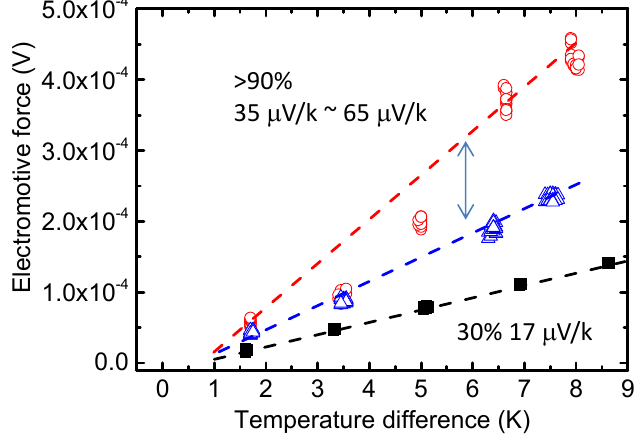
Figure 6. ( a ) Thermoelectric power factors and ( b ) thermoelectric figure-of-merit at 297 K in EG-mixed (open squares) and dimethyl sulfoxide (DMSO)-mixed (closed circles) PEDOT:PSS measured during the EG treatment (dedoping) process. Reproduced with permission from [49]. Copyright 2013 Nature Publishing Group.